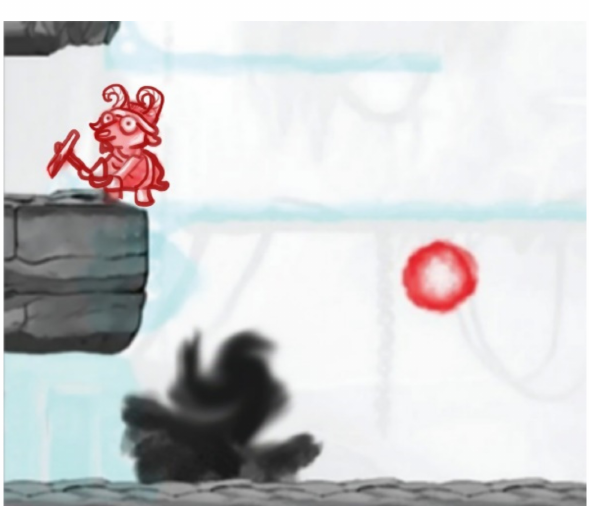
Figure 1. Illustration of Dig Rush. High-contrast red elements (miners and fireball) are seen by the amblyopic eye. Low-contrast blue elements (gold and platforms) are seen by the fellow eye. Gray elements (rocks and ground) are seen by both